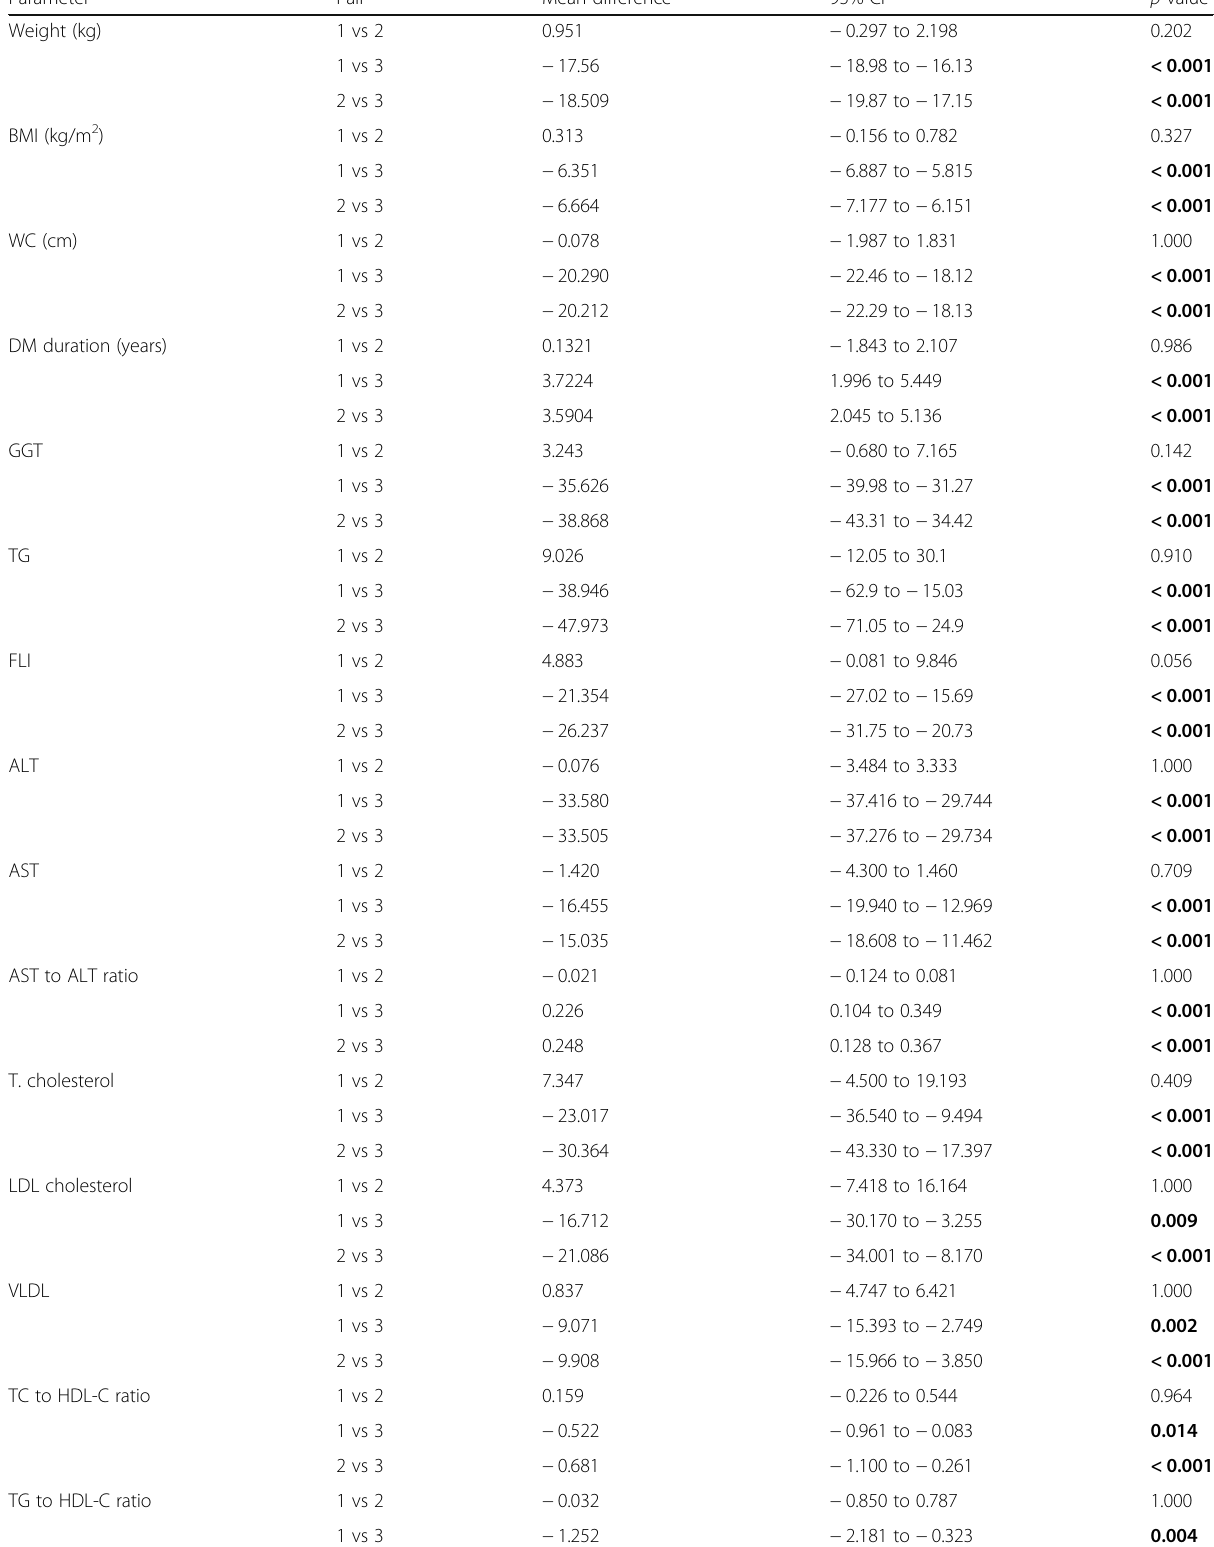
Table 2 Post hoc analysis with a Bonferroni adjustment for study